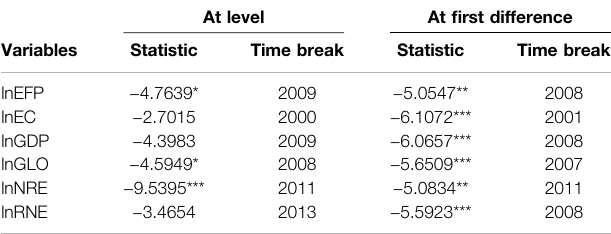
TABLE 4 | Results of Zivot-Andrew unit root test with structural breaks. At level At fi rst difference